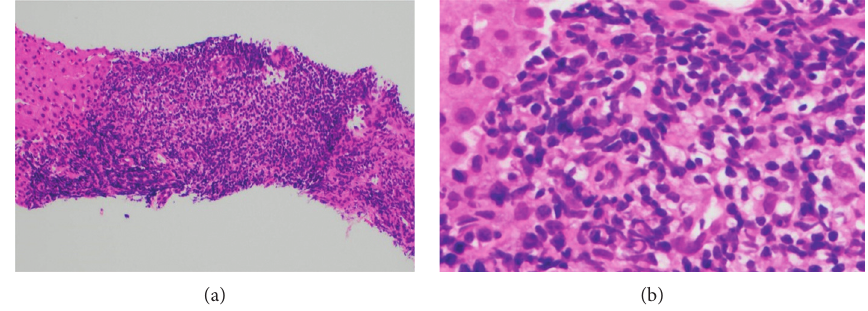
Figure 1: Low-grade marginal zone lymphoma confirmed by biopsy of liver (CD5 − and CD10 −